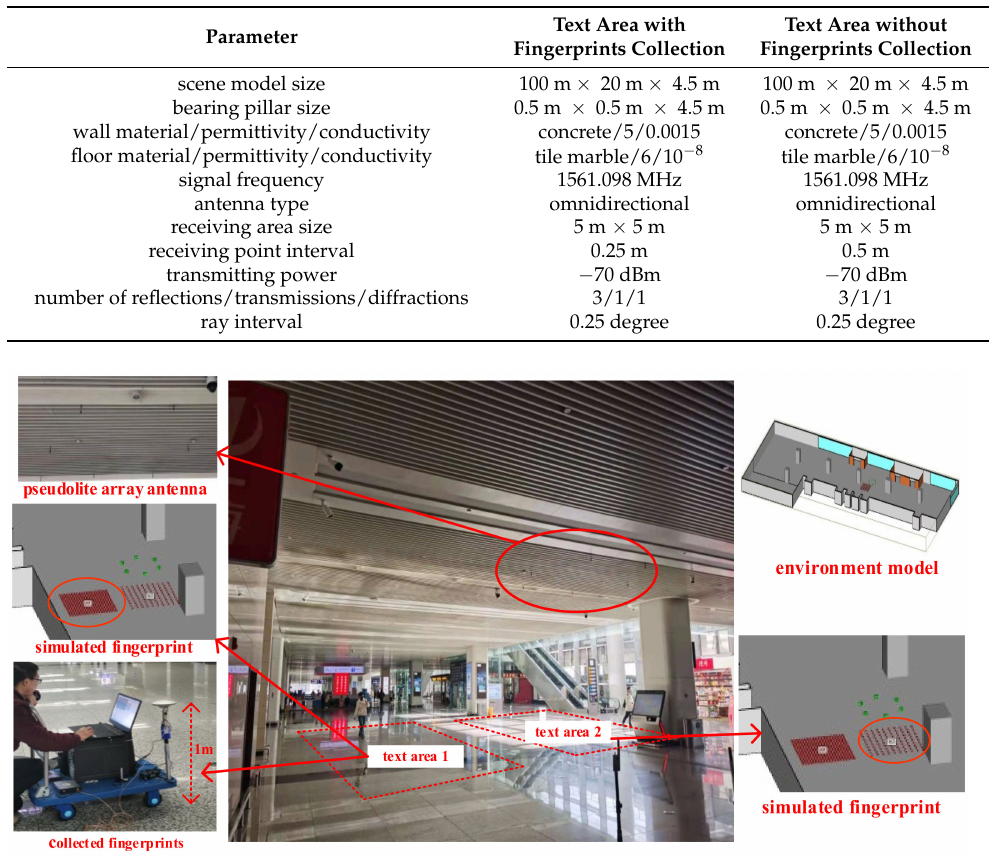
Figure 7. Experimental environment and